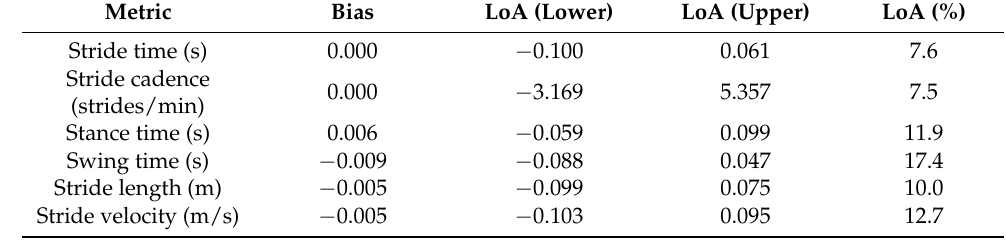
Table 5. Agreement between gait parameters measured in the pants pocket and the optoelectronic criterion. Bias and LoA from the Bland-Altman analysis are shown.